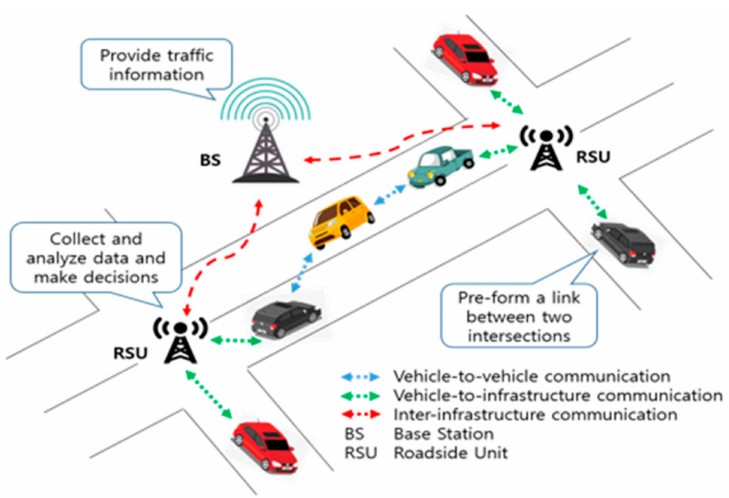
Figure 1. The architecture of the IRFMF routing